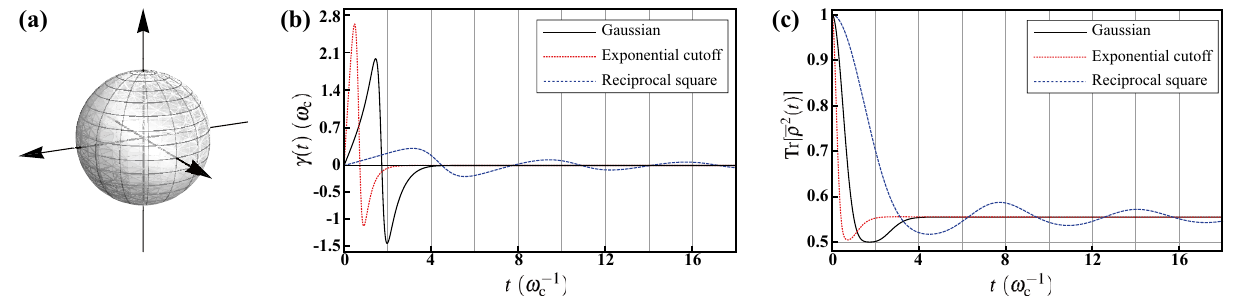
Figure 1. Decoherence under the HE with spherically symmetric probability distribution. ( a ) Visualization of 1 / 4 π of the probability distribution. As �(θ , φ) is a constant, the geometry the solid angular part �(θ , φ) = is a sphere of radius 1 / 4 π . ( b ) Time-evolution of the decay rates γ( t ) for the Gaussian (black solid curve), the exponential cutoff (red dotted curve), and the reciprocal square (blue dashed cruve) radial functions. Their behaviors are different to each other, as explained in the main text. The decay rates temporarily go down to negative values in some time periods, indicating transitions between indivisibility and full divisibility of the type ρ 2 ( t ) of random unitary. ( c ) The purities Tr governed by the isotropic depolarization with pure initial states for [ ] the three radial functions. There is a rivival in the time period of negative decay rate. Additionally, the final value of the purities is 5/9, rather than 1/2, reflecting that the final state is not the completely mixed